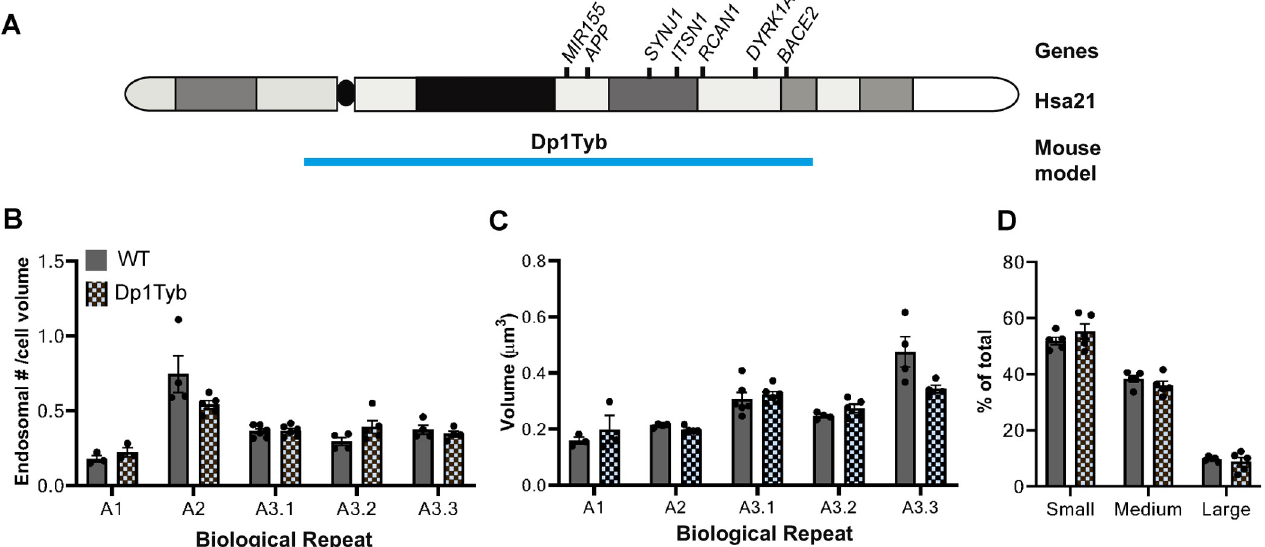
Fig 1. Number of endosomes per cell, endosomal volume distribution and mean volume of the largest endosomes are not different in WT and Dp1Tyb MEFs. A) Schematic of gene content of Dp1Tyb mouse model. B) No difference was found in the number of RAB5 + endosomes (normalised to cell volume) in WT and Dp1Tyb MEFs (Nested t-test p = 0.83, N = 5 biological repeats, N = 3–5 technical repeats). C-D) Endosomes were binned in three size categories: small (0-50th percentile of WT MEFs), medium (50-90th percentile of WT MEFs) and large (90-100th percentile of WT MEFs). The categories were determined using the endosomes in WT MEFs. C) No difference in RAB5 + endosome volume distribution was observed in WT and Dp1Tyb MEFs (Mann-Whitney U test). N = 5 biological repeats, N = 3–5 technical repeats. D) Volume of the RAB5 + endosomes classified as ‘large’ is not different in WT and Dp1Tyb MEFs (Nested t-test, p = 0.21). N = 5 of biological repeats (independent MEF lines), N = 3–5 technical repeats. Error bars = SEM .